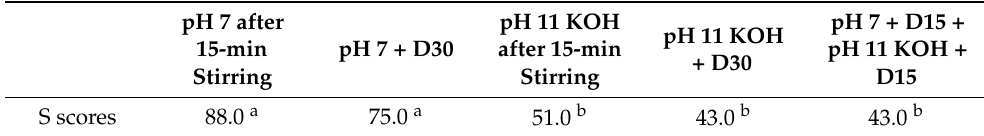
Table 3. S scores given by the panel members to the five conditions subjected to sensory